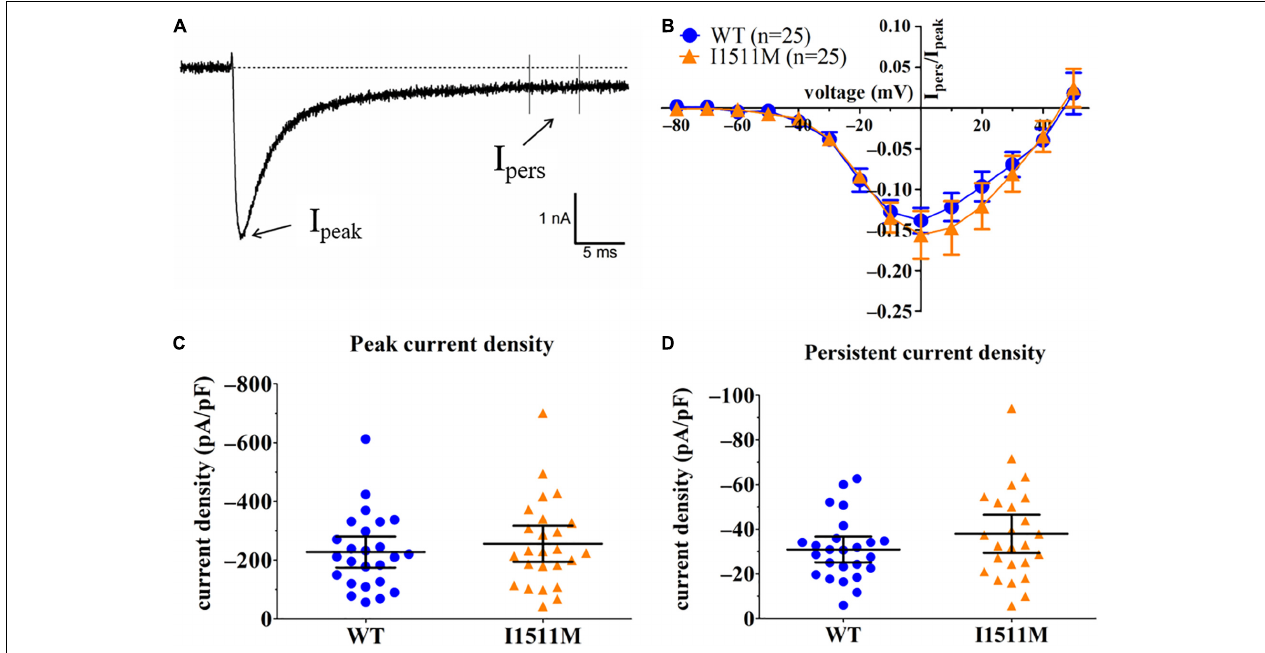
FIGURE 4 | Current density of both peak and persistent current is not affected by the I1511M mutation. (A) Representative current trace of a single cell transfected with hNa v 1.8 WT recorded at a voltage step to –10 mV. Arrows indicate time points of peak (I peak ) and persistent (I persist . ) sodium current. (B) Plot of current fraction remaining as persistent current (I pers /I peak ) against the respective voltage. (C) Comparison of peak current density of the cells between hNa v 1.8 WT and I1511M. (D) Comparison of persistent current density of the cells between hNa v 1.8 WT and